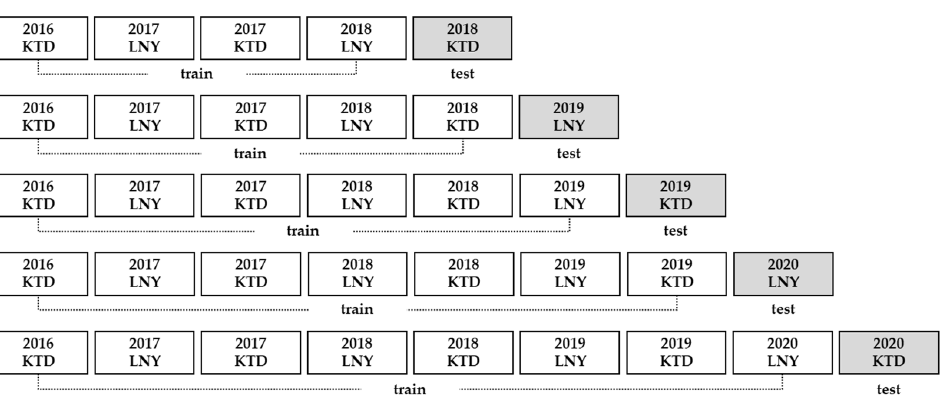
Figure 6. Train-test split; LNY: Lunar New Year, KTD: Korean Thanksgiving Day. Table 2. Performance of MLP models by the proposed method on the 25 mail center datasets .